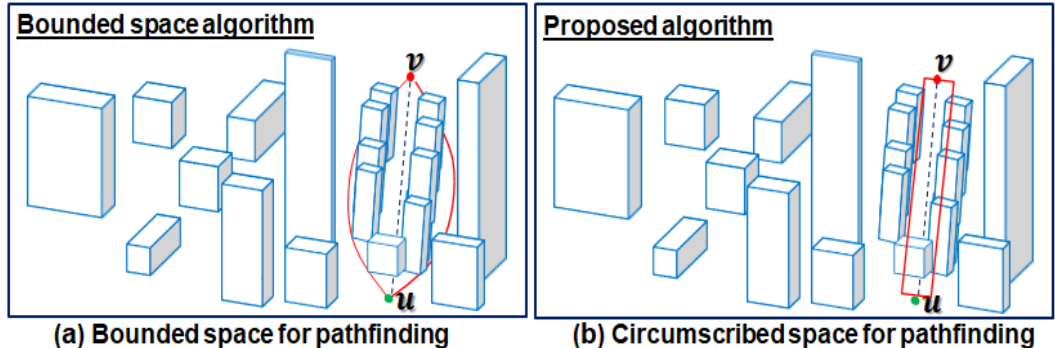
Figure 9. Reduced spaces for pathfinding with ( b ) and without ( a ) considering obstacles complexity.